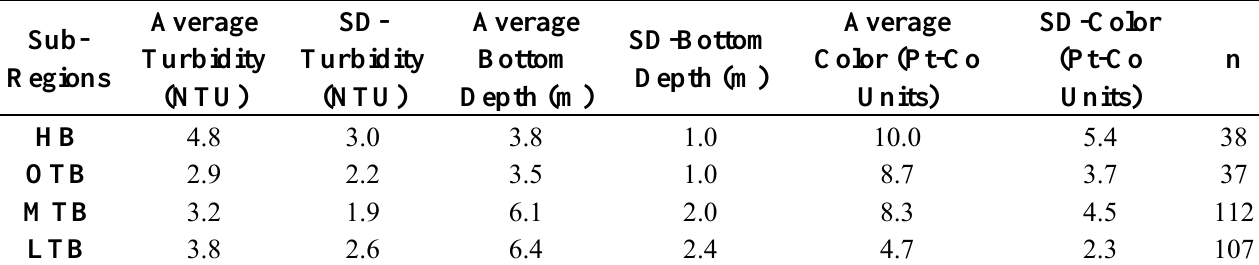
Table 3. Summary statistics of in situ data variables used in this study for the time period 2000–2007 by